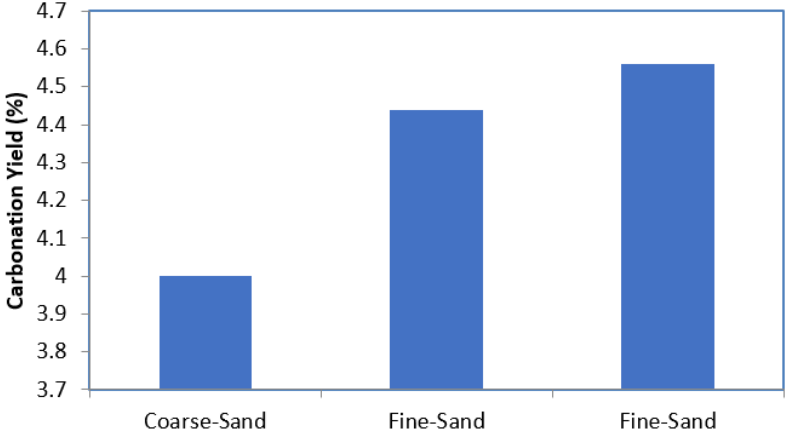
Figure 10. Carbonation yield at 20 bar, 6 h carbonation time, 200 h curing time.